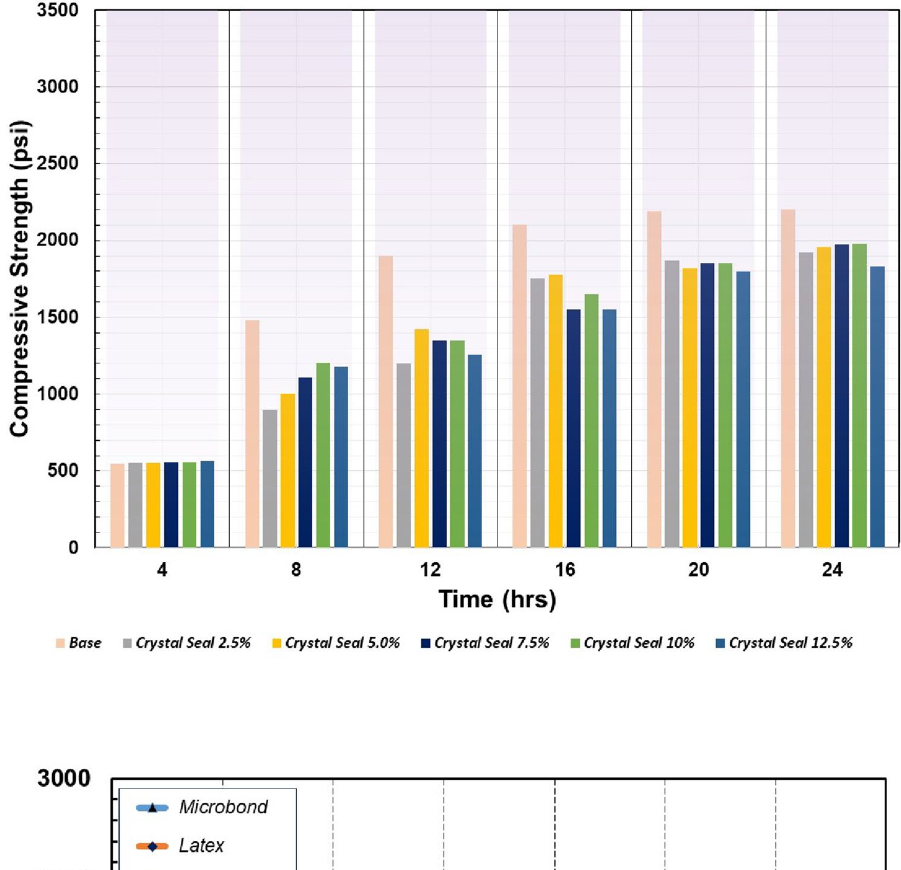
Fig. 15 Crystal seal compres- sive strength plot